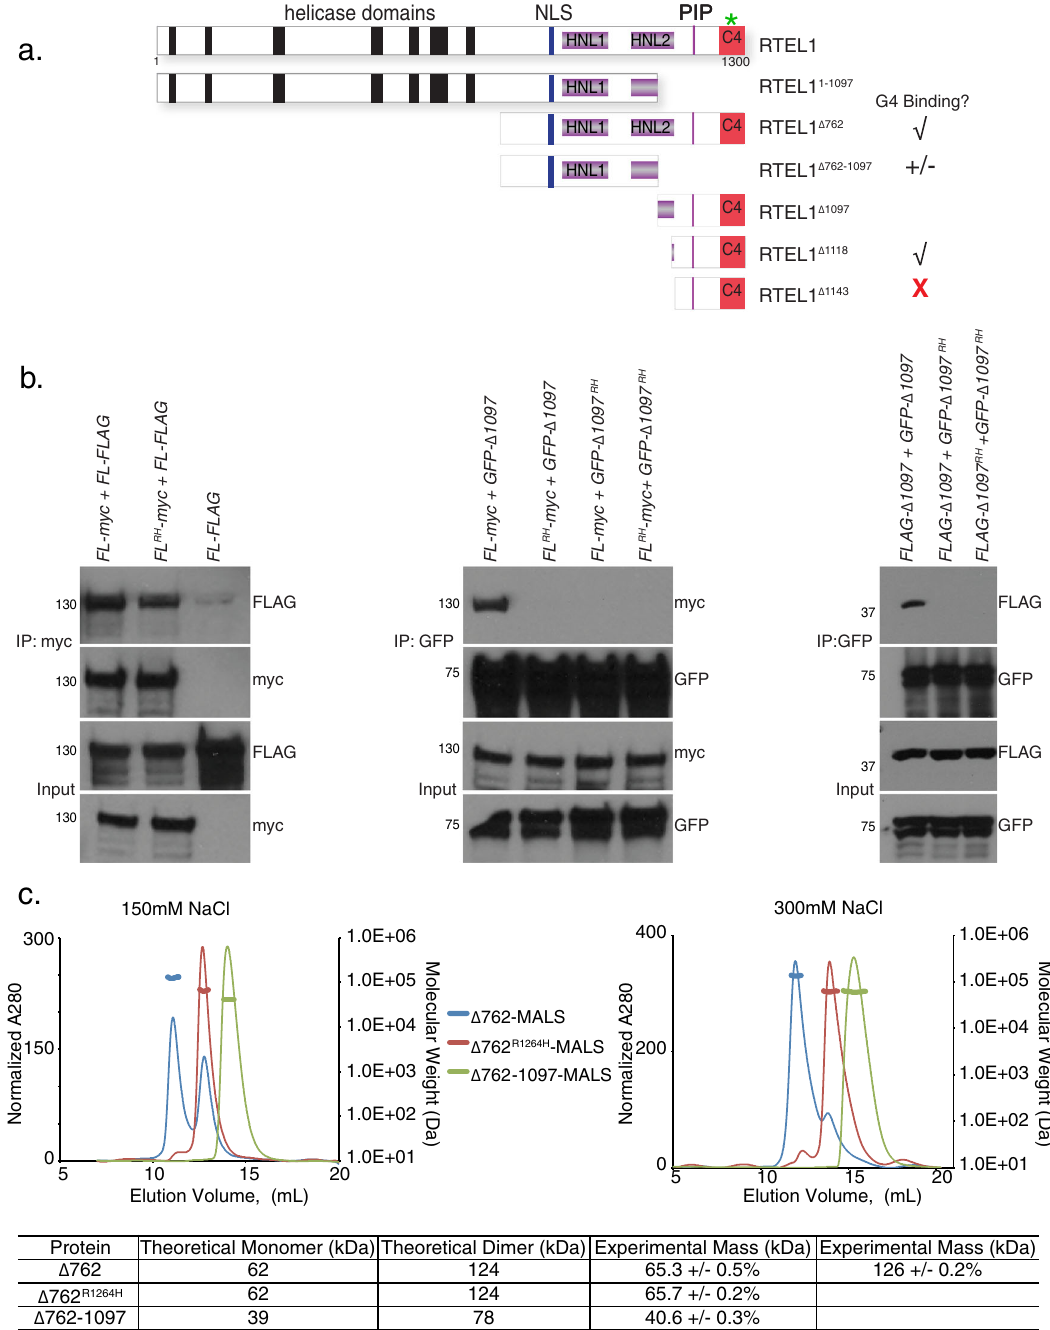
Fig. 1 Domain Analysis of RTEL1. a Schematic representation of RTEL1 proteins and constructs used in this study. The location of the RTEL1 R1264H mutation is indicated with a green star and G4 binding is illustrated. b RTEL1 interacts with itself in cells and the RTEL1 R1264H mutation disrupts interactions within the RING domain. Left, Myc immunoprecipitations from HEK293T cells co-expressing FLAG and myc-tagged RTEL1 (FL) and RTEL1 R1264H ( FL RH ) were carried out. Immunoblotting with FLAG indicates co-IP of both RTEL1 and RTEL1 R1264H . Center, immunoblotting with myc indicates co-IP of RTEL1 Δ 1097 ( Δ 1097), but not RTEL1 Δ 1097 R1264H ( Δ 1097 RH ) with GFP-tagged RTEL1 and RTEL1 R1264H . Right, immunoblotting with FLAG shows co-IP of RTEL1 Δ 1097 , but not RTEL1 Δ 1097R1264H . Molecular weight markers, KDa are shown. All immunoblotting experiments were repeated at least three times with similar results. c Oligomeric states of RTEL1 proteins were determined by SEC-MALS analysis of RTEL1 Δ 762 (blue), RTEL1 Δ 762R1264H (red), and RTEL1 Δ 762-1097 (green) at 150 and 300 mM NaCl. Normalized A280 are shown and the calculated molecular mass is shown as a line in the corresponding color across each peak with the secondary scale on the right. The expected and calculated molecular weights are shown (see also Supplementary Fig. 1). combination with hydrophobic interactions that are stabilized at RTEL1 Δ 762 dimeric species but had no effect on the oligomeric higher ionic strength. Hence, the RING domain of RTEL1 is a state of either RTEL1 Δ 762R1264H or RTEL1 Δ 762-1097 proteins (Fig. 1c). These results suggest that dimerization of the C- dimerization domain and the RTEL1 R1264H mutation disrupts terminal RTEL1 domain is dependent on the RING domain in that function in vitro and in cells. NATURE COMMUNICATIONS| (2021) 12:3016